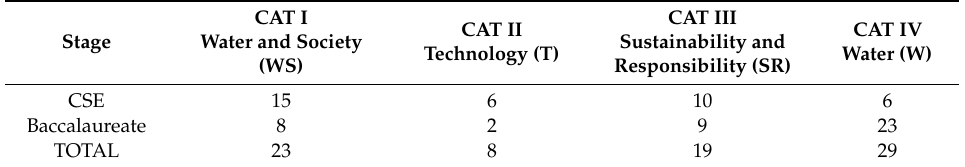
Table 4. Number of references in compulsory secondary education and in baccalaureate in the di ff erent categories of the